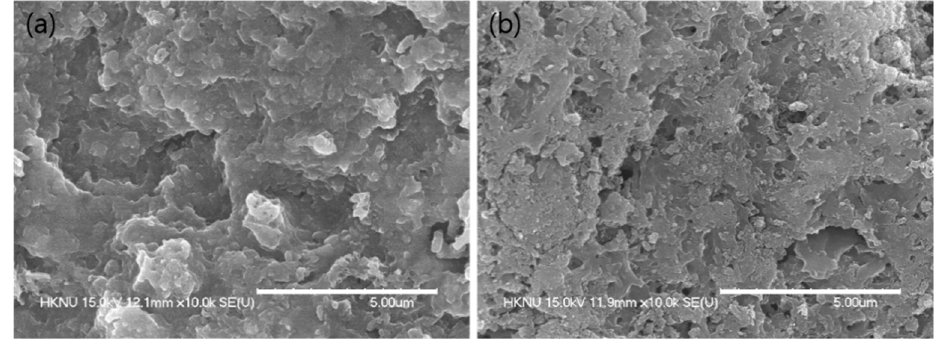
Figure 1. Surface morphologies of Fe-CMB ( a ) before and ( b ) after Sb(V) adsorption. Analyzed using a field emission scanning electron microscope. Table 1. Elemental composition (weight %) of Fe-CMB obtained from energy dispersive spectrometer.